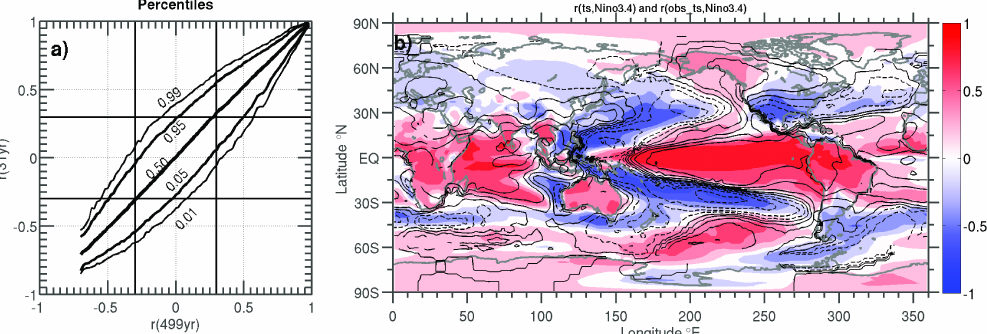
Figure 1. (a) The percentiles of correlations found in 31-year segments between the model (see Sect. 2) surface temperature (TS) at each grid point and the model-calculated Niño 3.4 index ( y axis), plotted against the corresponding correlations for the whole 499 years of data ( x axis). The lines are the 1st, 5th, 50th, 95th, and 99th percentiles, with the lowest lines indicating the lowest percentiles (i.e. the bottom line is the 1st percentile). (b) The shading is the correlation between of the entire 499 years of TS at each grid point and the model-calculated Niño 3.4 index, both calculated from the GFDL CM2.1 data, also described in Sect. 2. The black contour lines are the correlation coefficients (spacing of 0.2) of observed surface land–sea temperatures to its corresponding Niño 3.4. Solid lines are positive values, while dashed lines are negative. These observations were calculated using the last 50 years of annual mean GISTEMP_ersst observational data (GISTEMP-Team, 2015). Data set is described by Hansen et al.